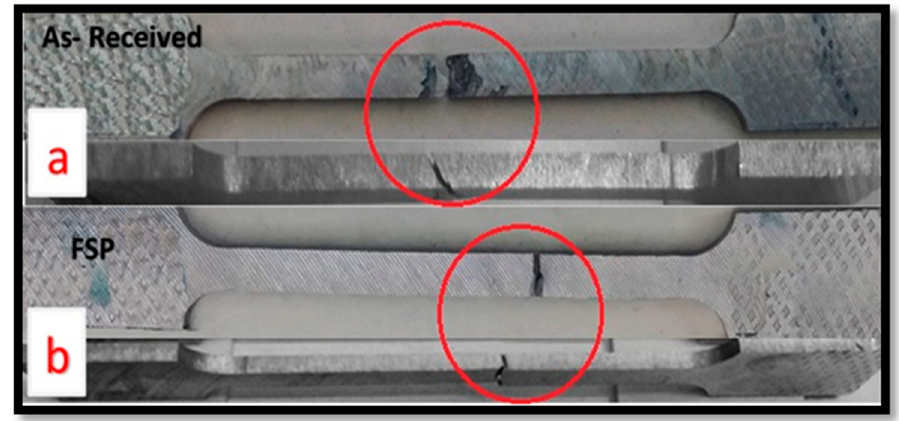
Materials 2017 , 10 , 1053